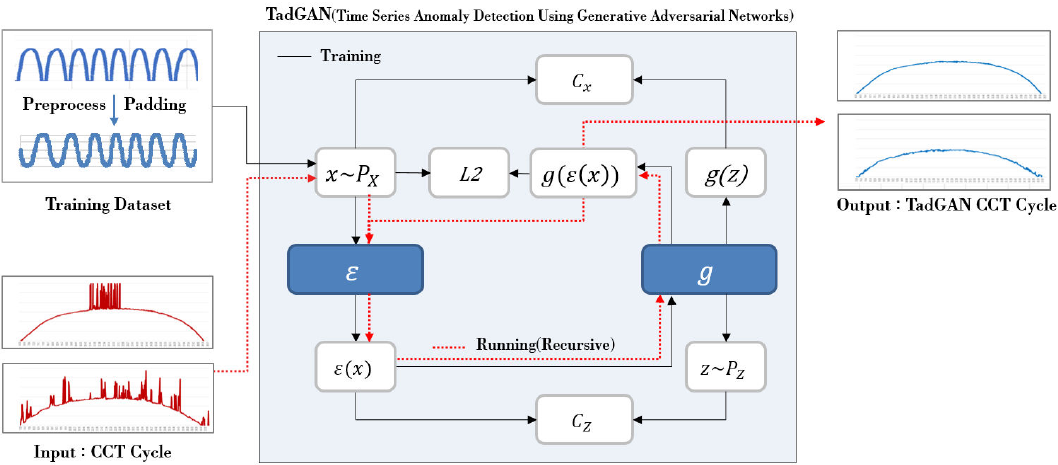
Figure 1. Generation of a TadGAN-based natural light color temperature cycle .